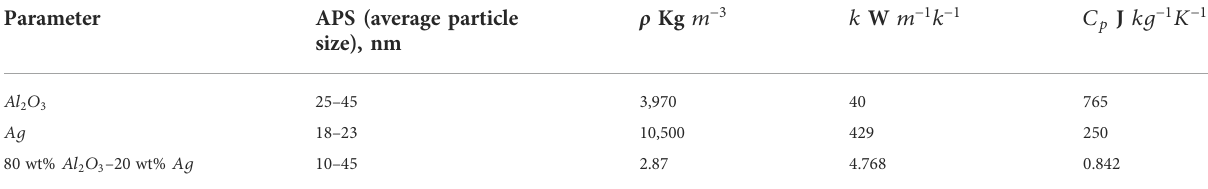
TABLE 1 Thermophysical features of the